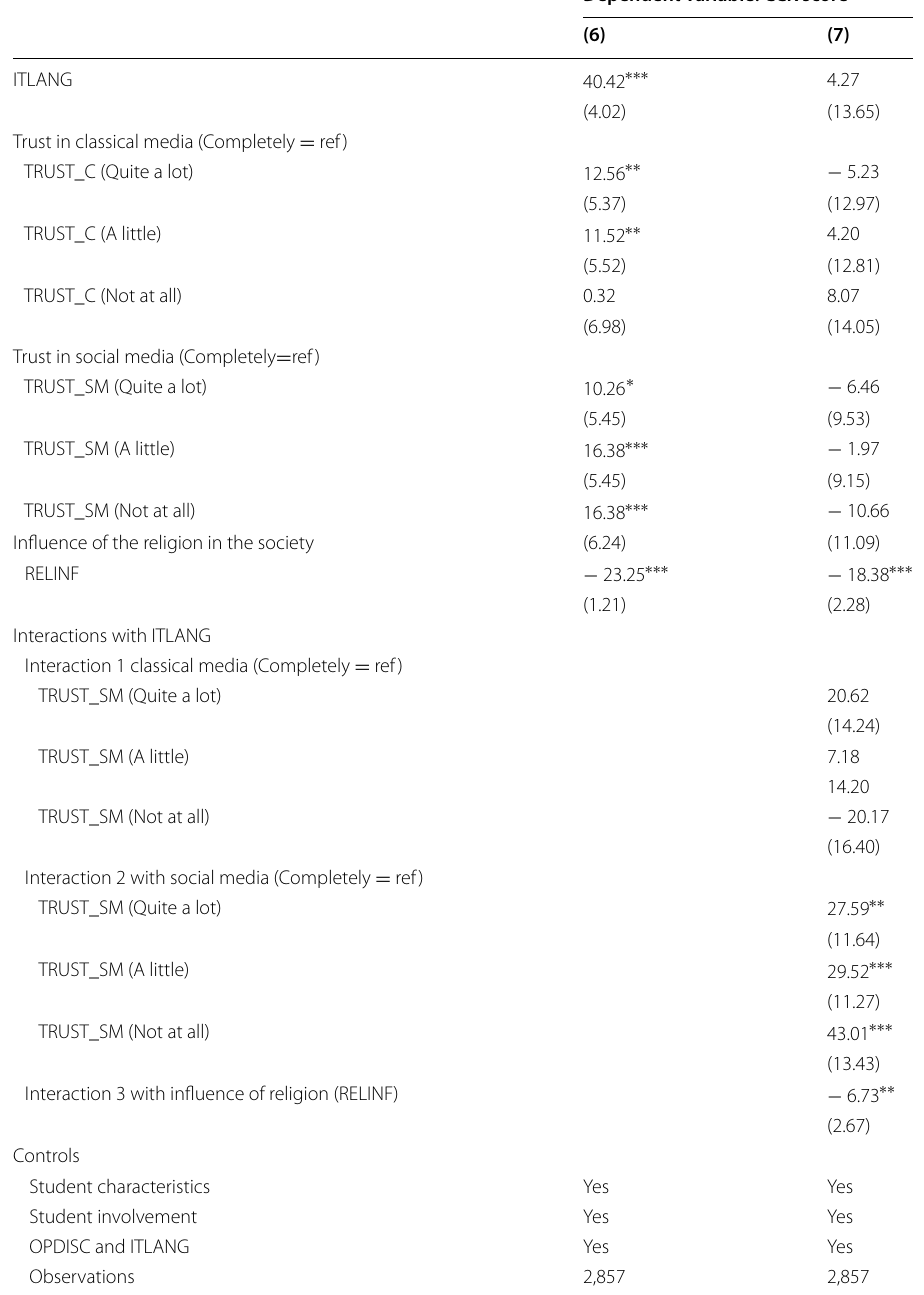
Table 4 Random effects models: Bringing interactions